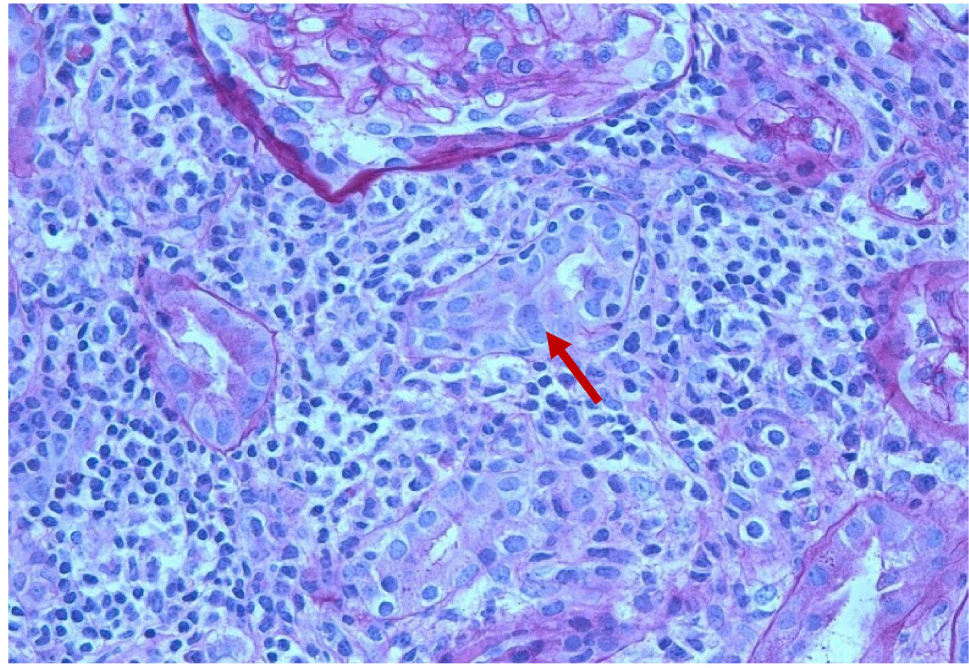
Figure 2. Renalbiopsy. Lightmicroscopy(H&E)showingtubulitis(redarrow)withsevereinterstitialinflammation. The patient was treated with albumin/diuretic infusions for the symptomatic relief of edema and the weight trended down to near her baseline at discharge. Due to severe TIN and NS, a course of steroids, prednisone 60 mg daily, was started with gradual tapering over six weeks. Serum creatinine trended down to 1.13 mg/dL at discharge. Due to concerns of DIL, ethosuximide was changed to zonisamide after consultation with neurology and switched again after three weeks to sodium valproate for better